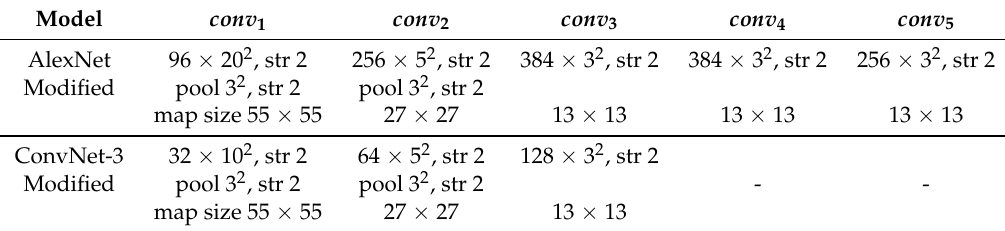
Table A2. Comparing network architectures: filter number × filter size (e.g., 96 × 20 2 ), filter stride (e.g., str 2), pooling window size (e.g., pool 5 2 ) and the output feature map size (e.g., map size 55 ×